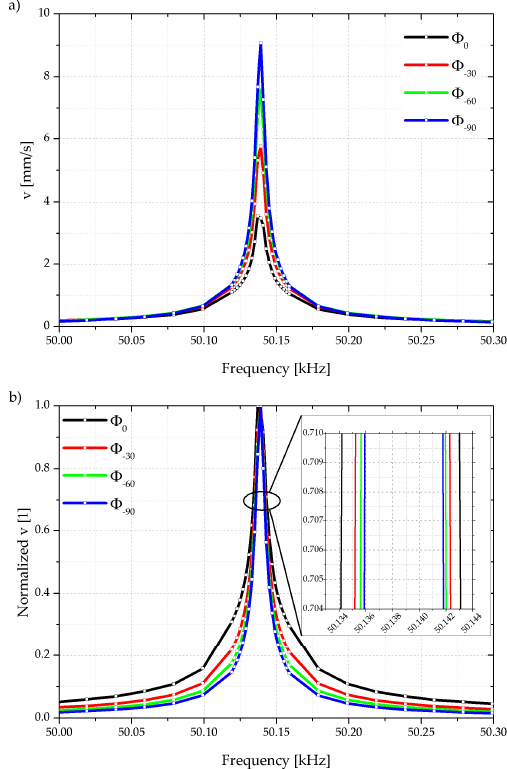
Figure 10. Optically measured absolute velocity ( a ) and normalized velocity of cantilever tip ( b ) when applying a frequency-dependent, phase shifted excitation. The inserted lines serve as guide to the eyes. Simultaneously the oscilloscope records the amplified electrical differential voltage at the Wheatstone bridge at OSC–CH2 and the frequency spectrum is shown in Figure 11. The figure shows the measured and the simulated values, whereas the latter are based on the equivalent circuit from Figure 5 and inserted with colored lines.